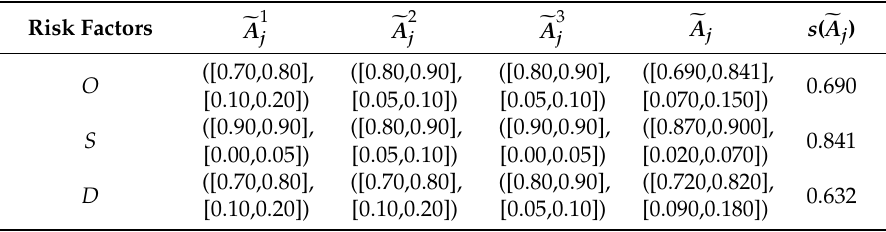
Table 5. Relevant parameters of subjective